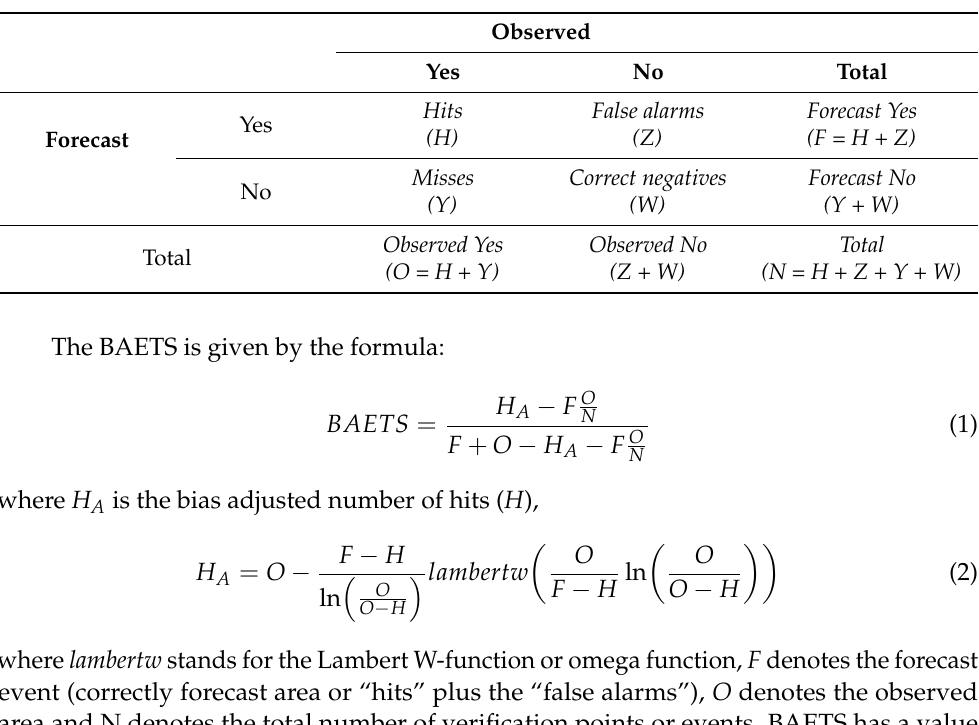
Table 2. Contingency table illustrating the counts used for bias adjusted equitable threat score (BAETS)